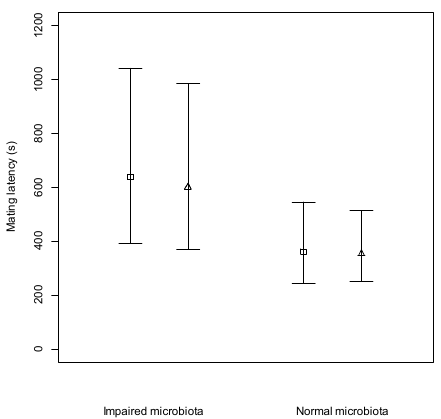
Figure 1. Mean copulation latency and 95% confidence intervals of old (square markers) and young (triangular markers) males, with either their microbiota impaired or intact (Normal) when placed with a single female.